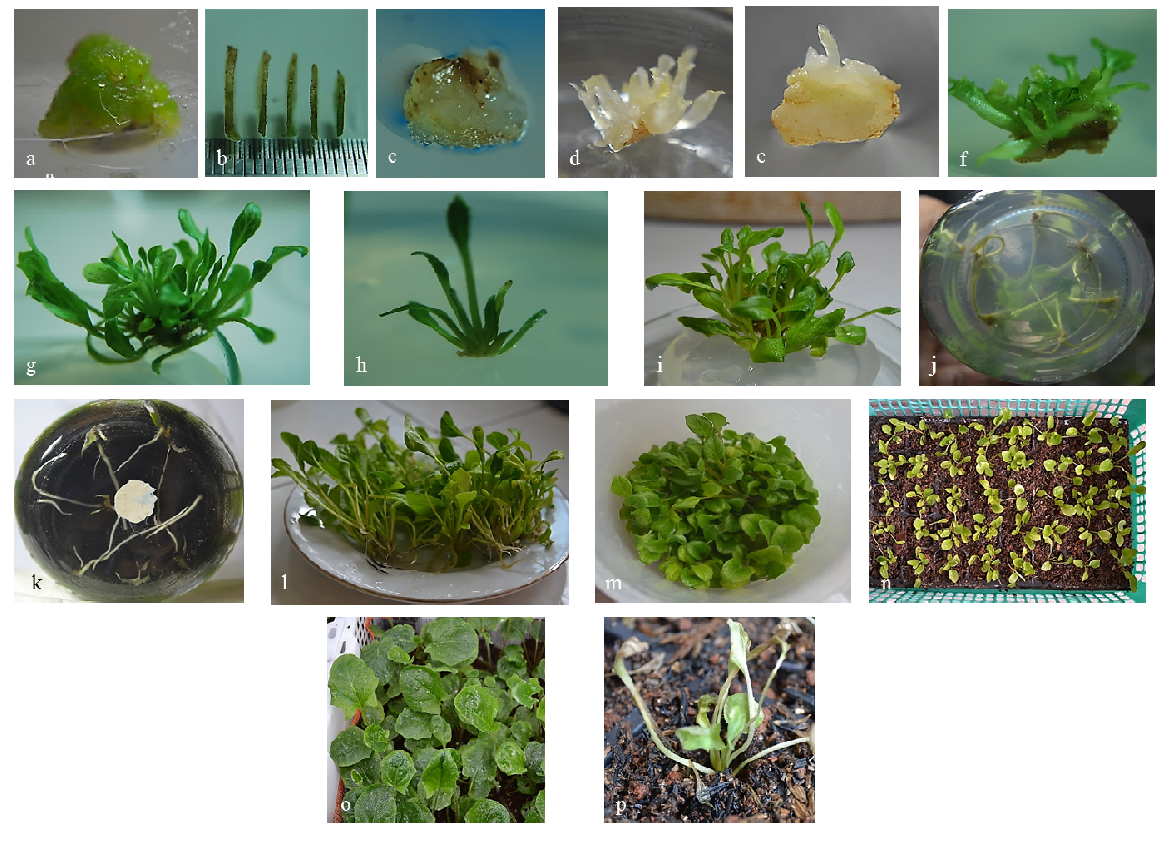
Fig. 7. Axillary shoot initiation to its acclimatization derived from TCL explants and adenine sulphate application in in vitro mass propagation protocol of gerbera. a. Enlarged-shoot tip ready used as explant source for TCL treatment resulted from culturing the shoot tip on half-strength MS medium supplemented with 1.5 mg/l TDZ and 0.25 mg/l BA ± 2 months after culture. b. Sizes of slicing explants used for tTCL and lTCL were < 1.0 mm. c. Regenerated small nodulars on the first slicing position of tTCL explant of ‘Black Jack’ on half-strength MS medium containing 0.25 mg/l BAP 16 days after dark incubation in the first experiment, d. Regenerated shoots derived from the first slicing positon of tTCL explant of ‘Black Jack’ on half-strength MS medium containing 0.25 mg/l BAP 30 days after dark incubation in the first experiment, e. Regenerated shoots derived from lTCL explant on half-strength MS medium containing 0.25 mg/l BAP 35 days after dark incubation in the first experiment, f. Regenerated shoots derived from the first slicing positon of tTCL explant of ‘Black Jack’ on half-strength MS medium containing 0.25 mg/l BAP 1.5 months after dark incubation in the second experiment, g. Regenerated shoots derived from the first slicing positon of tTCL explant of ‘Black Jack’ on half-strength MS medium containing 0.25 mg/l BAP 2.0 months after dark incubation in the second experiment, h. Single shoot cultured on half-strength MS medium supplemented with 0.25 mg/l BAP 5 days after subculture for shoot multiplication purpose, i. Proliferated shoots derived from single shoot cultured on half-strength MS medium supplemented with 0.25 mg/l BAP and 60 mg/l AS 1.5 months after culture, j. Rooting shoots on half-strength MS medium containing 0.1 mg/l BAP and 0.5 mg/l NAA without AC 1.0 month after culture. k. Rooting shoots on half-strength MS medium containing 0.1 mg/l BAP and 0.5 mg/l NAA with 2 g/l AC 1.5 month after culture, l. Plantlets with 4-9 leaves and 2-6 roots ready for acclimatization, m. Plantlets treated with 1% pesticide solution (fungicide and bactericide) for 3 min before their planting in acclimatization media, n. Growth of plantlets 15 days after acclimatization, o. Vigorous and healthy plantlet growth 2.5 months after acclimatization, p. Plantlet with wilted leaves due to dehydration 10 days after